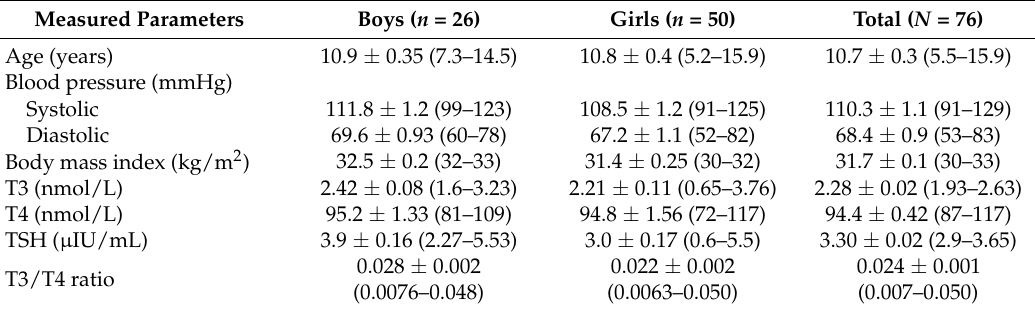
Table 3. Comparison of measured variables between obese boys and girls.